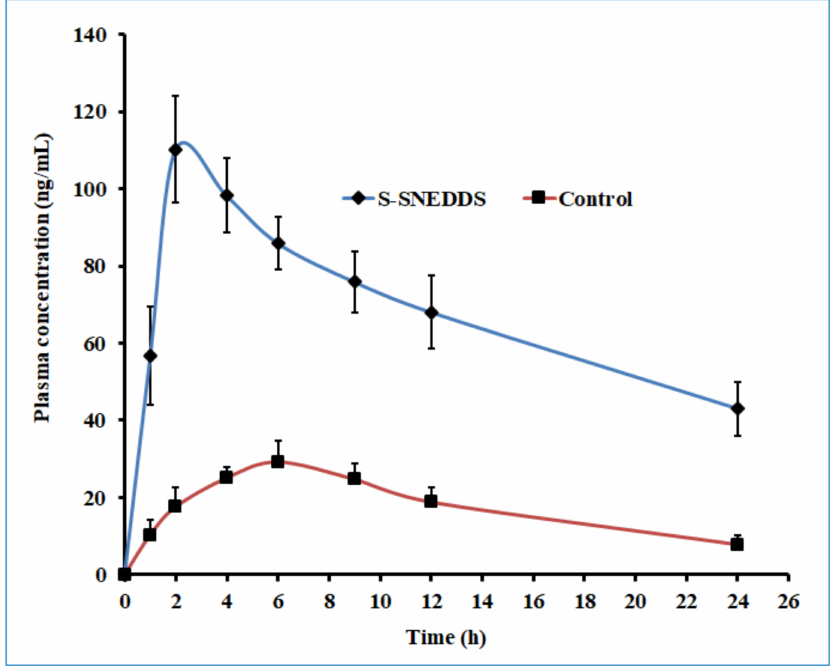
Figure 14. Mean plasma concentration-time profile of prepared solid self-nanoemulsifying drug delivery system (S-SNEDDS) and sertraline (control) in Wistar rats following oral administration. Data represented are mean ± SD ( n = 6). Table 6. Mean pharmacokinetic parameters of self-nanoemulsifying drug delivery system